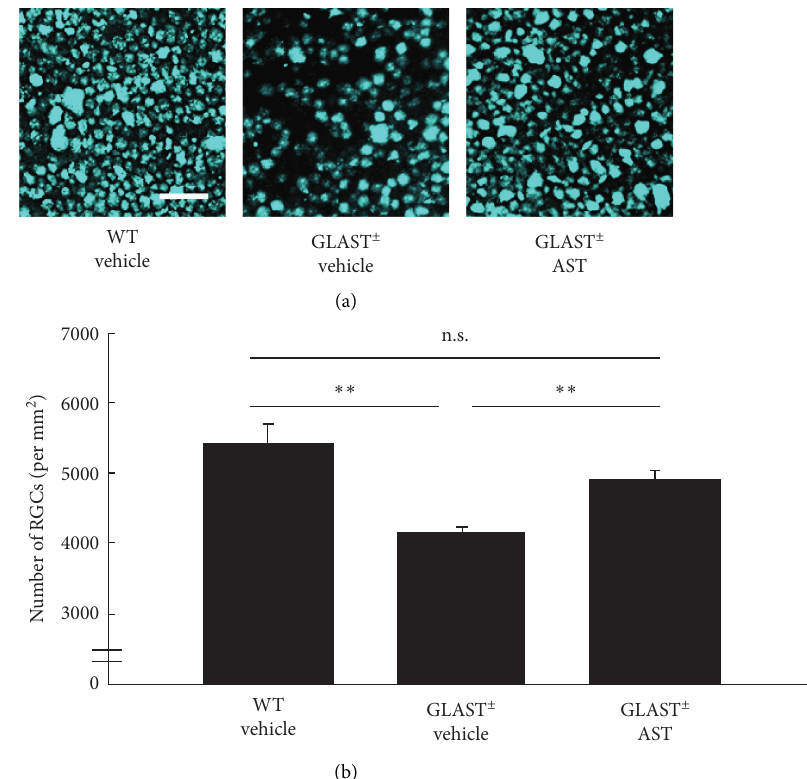
Figure 2: AST-mediated protection of RGCs detected by retrograde labeling. (a) Retrograde-labeled RGCs. Scale bars: 50 μ m. (b) Quantification of retrograde-labeled RGCs. Note that the RGC number was significantly lower in Glast ± mice than in control mice, while loss of RGC was suppressed by 60mg/kg/day AST administration. ∗∗ P < 0 . 01. n.s.: not